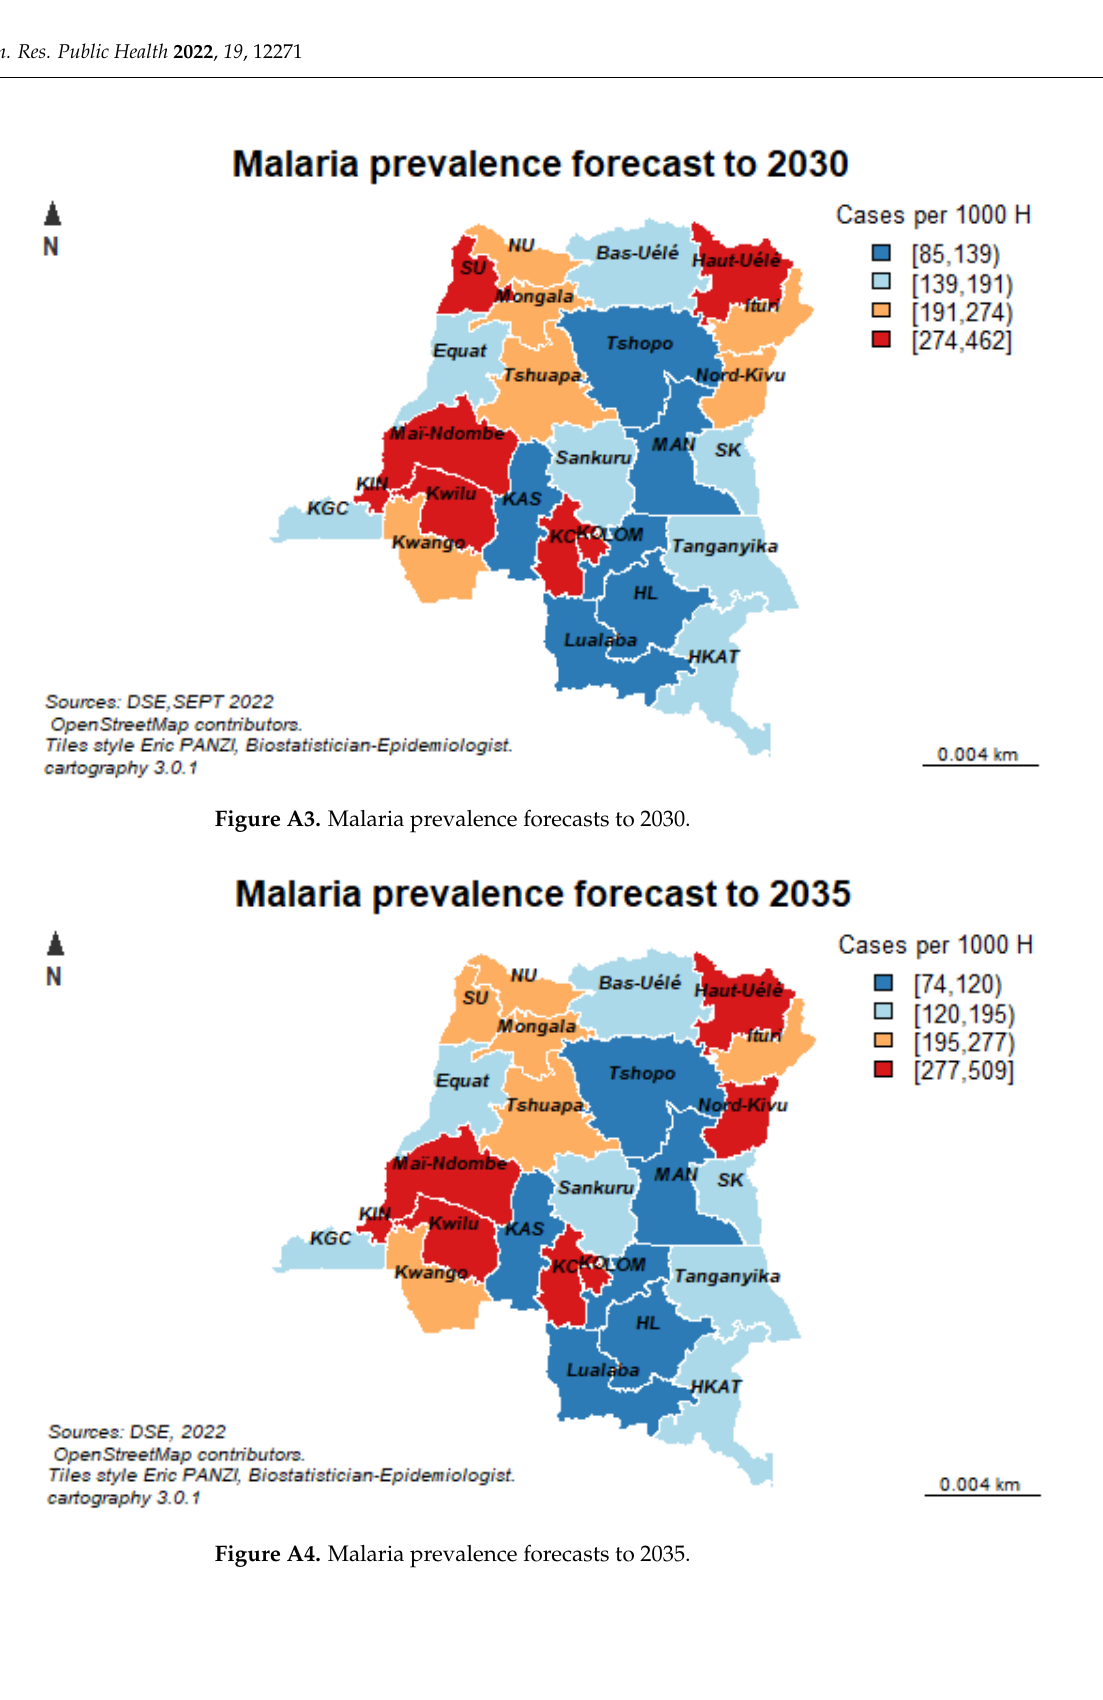
Int. J. Environ. Res. Public Health 2022 , 19 , x FOR PEER REVIEW 24 of 30 Figure A1. Malaria prevalence forecasts to 2020.